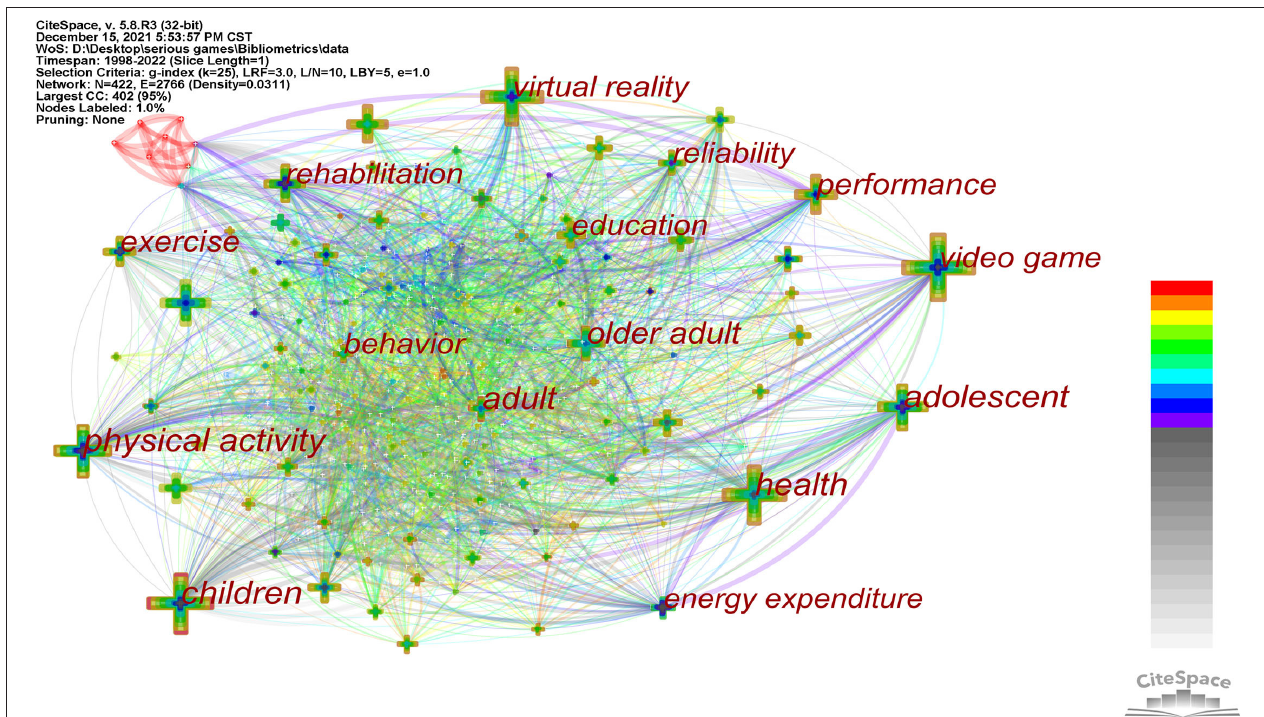
FIGURE 5 | Keywords co-occurrence